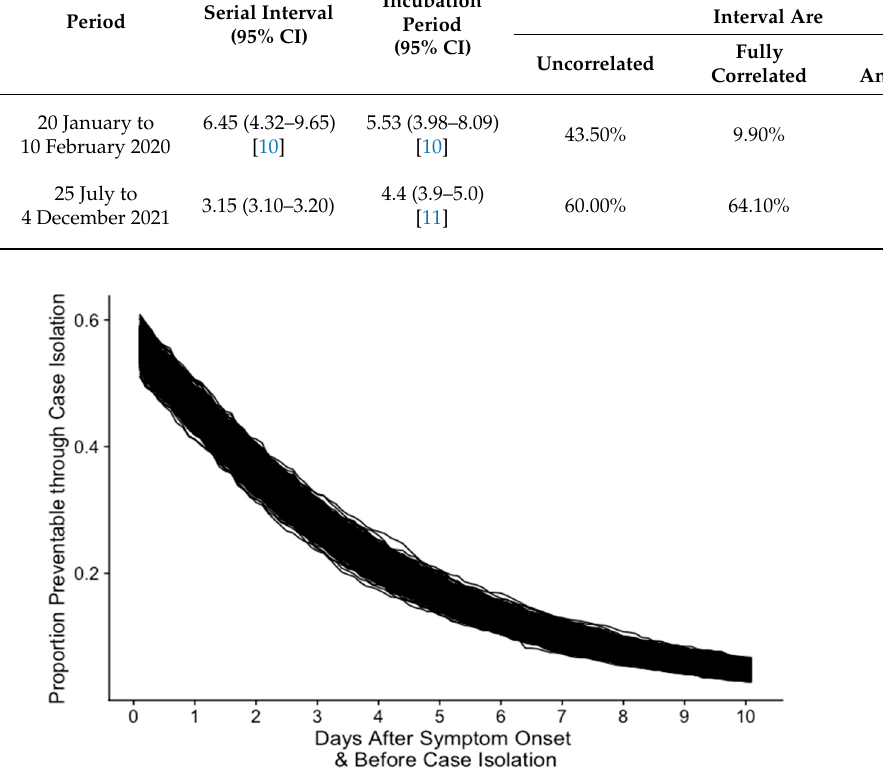
Figure 4. Proportion of potentially preventable onward transmission based on the time to case isolation (days) after symptom onset. These estimates are based on parameters from scenarios where there are no social distancing measures. Table 1. Overview of the scenarios tested and the corresponding estimates for the percentage of transmission that may be attributable to pre-symptomatic infections.